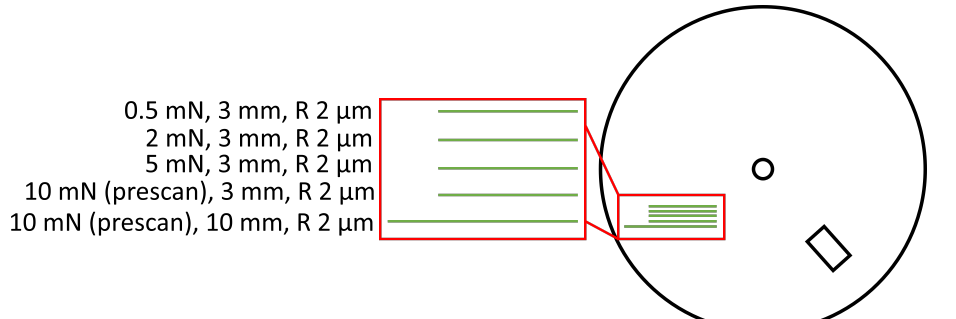
Figure 3. Representation of the watch dial with standardized scratches. The red rectangle represents the acquisition zone.